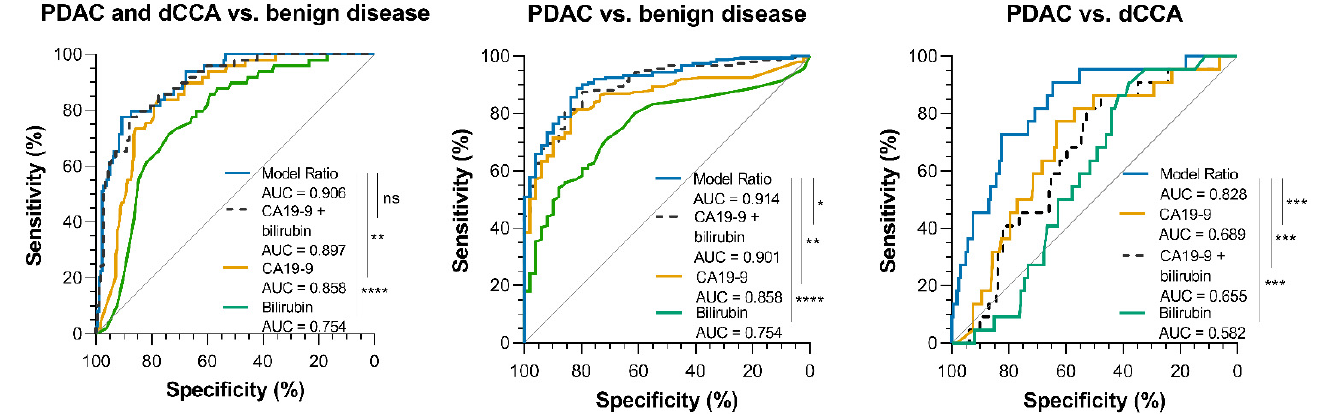
Figure 4. ROC curves and AUC comparisons of the ‘Model Ratio’ with the models using only CA19-9 and bilirubin. Malign vs. benign; Model ratio vs. CA19-9: p = 0.002 (**: p < 0.01), Model ratio vs. bilirubin: p = 3.0 × 10 − 7 (****: p < 0.0001) Model ratio vs. CA19-9 + bilirubin: p = 0.071 (ns: p > 0.05) PDAC vs. benign; Model ratio vs. CA19-9: p = 0.0011 (**: p < 0.01), Model ratio vs. bilirubin: p = 3.3 × 10 − 7 (****: p < 0.0001); Model ratio vs. CA19-9 + bilirubin: p = 0.048 (*: p < 0.05) PDAC vs. dCCA; Model ratio vs. CA19-9: p = 0.0009 (***: p < 0.001) Model ratio vs. bilirubin: p = 0.0002 (***: p < 0.001) Model ratio vs. CA19-9 + bilirubin: p = 0.0004 (***: p < 0.001).